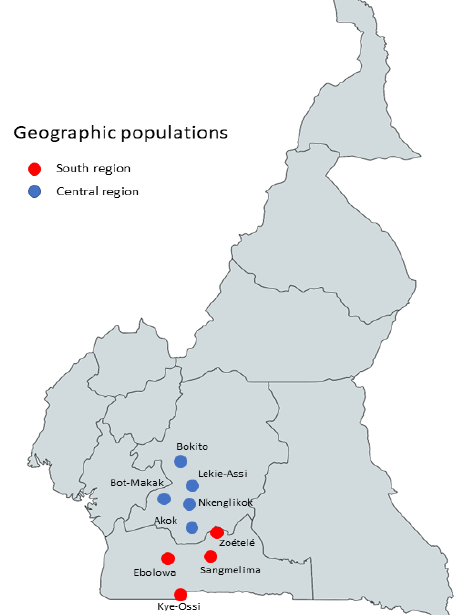
Figure 7. Sampling areas/geographic populations in Central and South regions. Table 9. Number of samples used for evaluation of genetic and morphological diversity per region and geographic population.